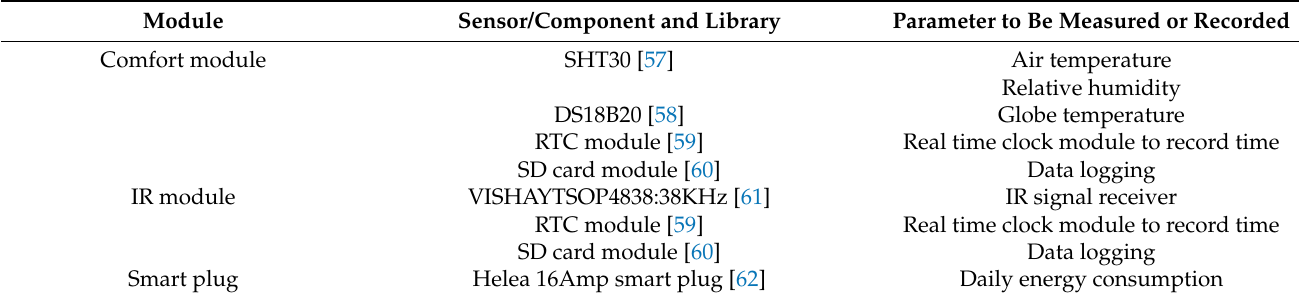
Table 1. Sensors and components.